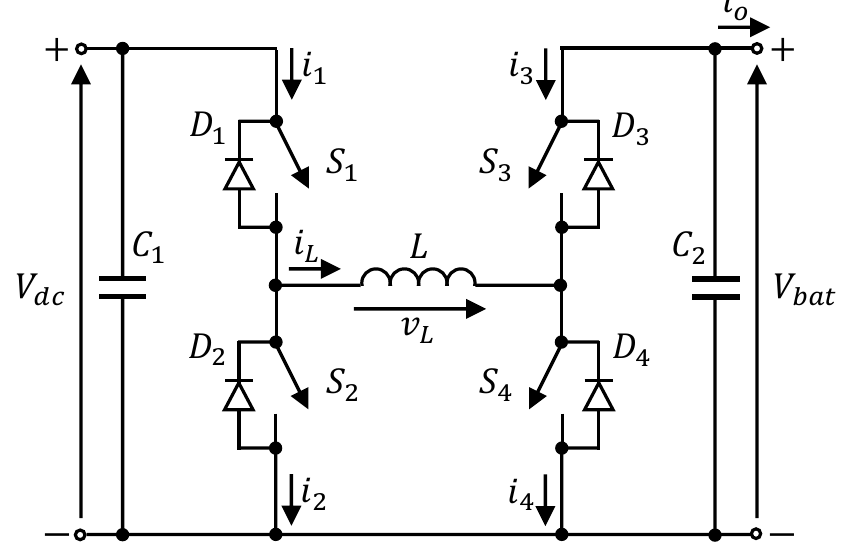
Figure 3. Non-isolated hard-switched bidirectional cascaded buck and boost